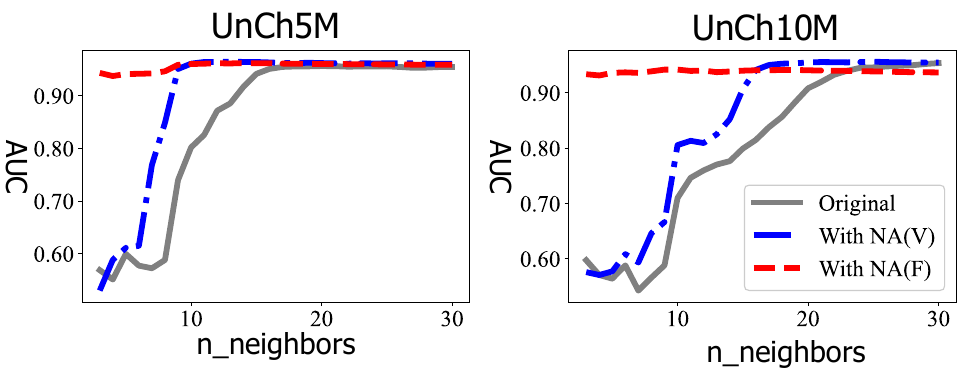
Figure 7. The outlier scores produced by MiPo + LOF (original) can be processed by NA to improve the results. NA(V) and NA(F) refer to setting NA’s parameter n _ neighbor to be varied or